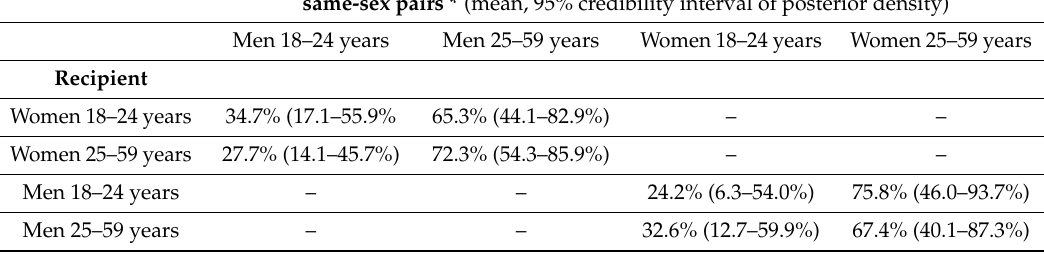
Table 5. Phylogenetically estimated sources of HIV-1 acquisition among male and female study participants by